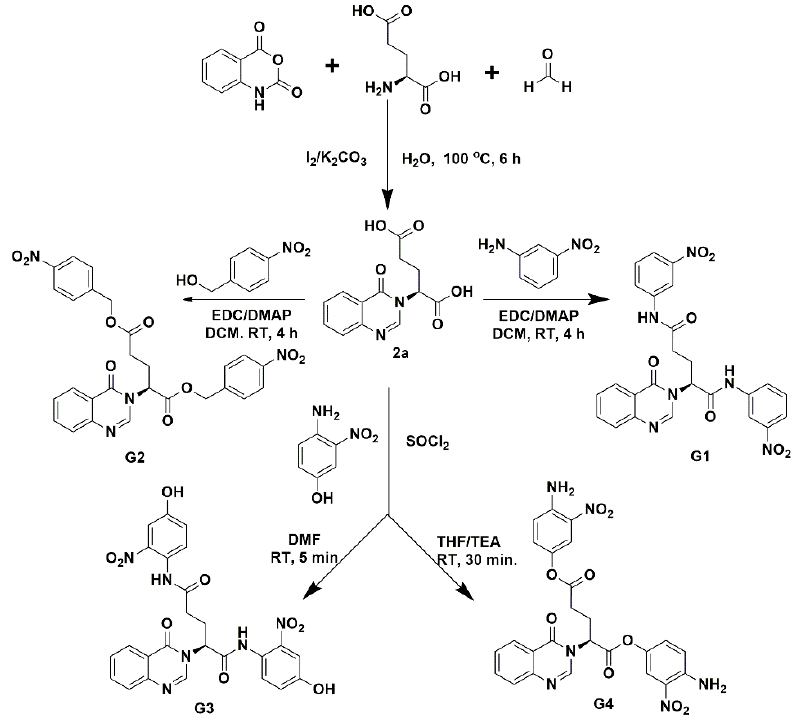
Figure 2. Synthesis of fragment-based compounds containing glutamine- or glutamic acid-derived peptidomimetic backbone, quinazolinone moiety, and nitro-functionalized phenyl derivatives.